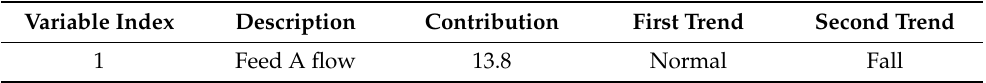
Table 6. The contributions of abnormal variables in 1 min for Mode 5 fault 6.